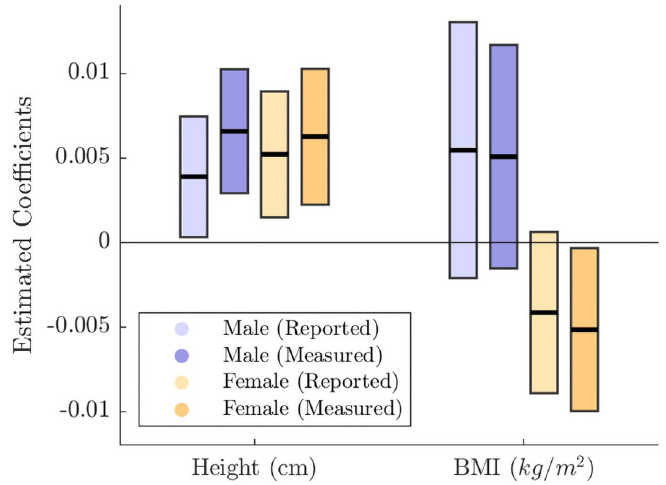
Fig 3. Comparison of reported and measured body measures. We report estimated coefficients and bootstrapped 90% confidence bands. We provide results from reported body measures (Reported) and measured body measures (Measured). Note that the unit for height is converted into centimeter